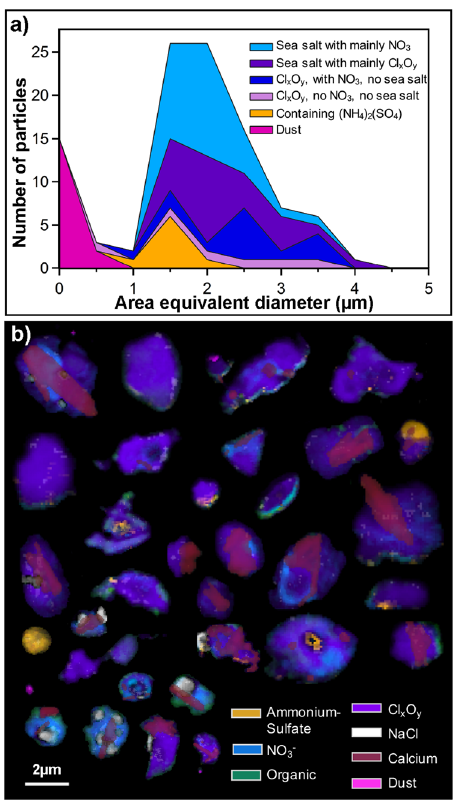
Fig. 2 Individual particles analyzed by STMX/NEAXFS. a The size distribution of classi fi ed particles based on the rule-based particle classi fi cation (see “ Methods ” ); ( b ) composite image of individual particles (three-dimension visualization) that contain amounts of Cl x O y , compiled from chemical maps from different fi elds of